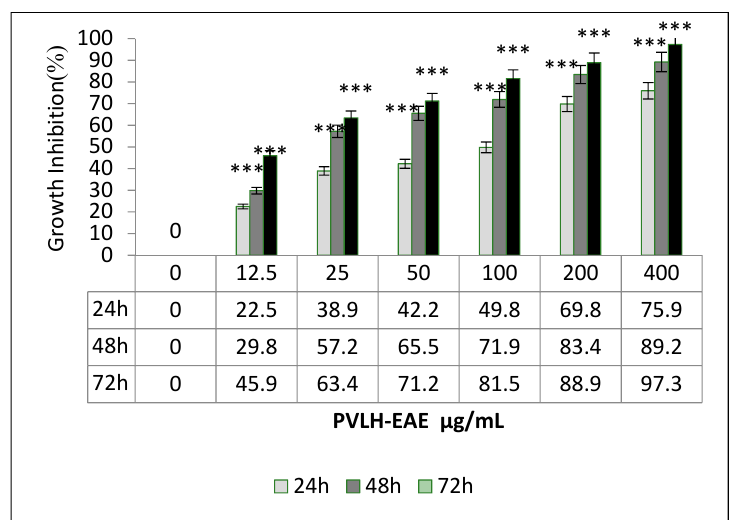
Figure 2. Growth inhibition effects of PVLH-EAE on MCF-7 in different time (24, 48 and 72 h) and concentration (12.5, 25, 50, 100, 200 and 400 µg/mL). The longer incubation time and increasing concentrations of PVLH-EAE lead to more percent inhibition of cell growth (***: p value < 0.001). All in vitro experiments were performed in triplicate and expressed ad the mean ± standard deviation.